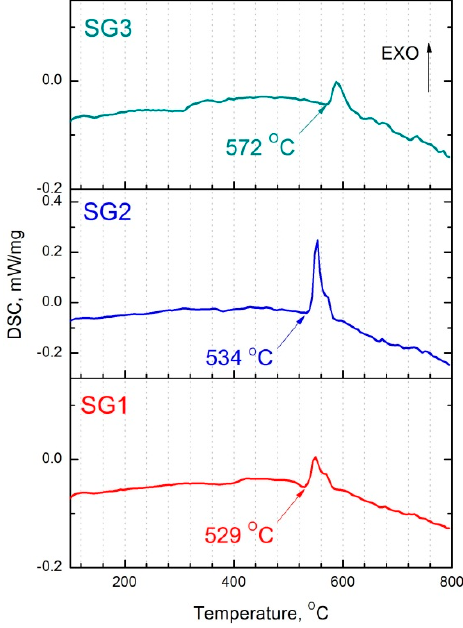
Figure 2. Differential scanning calorimetry (DSC) curves of samples after melt